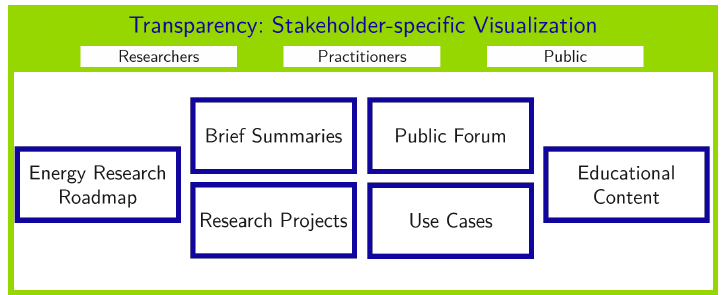
Figure 8. Basic functionalities of Transparency and their